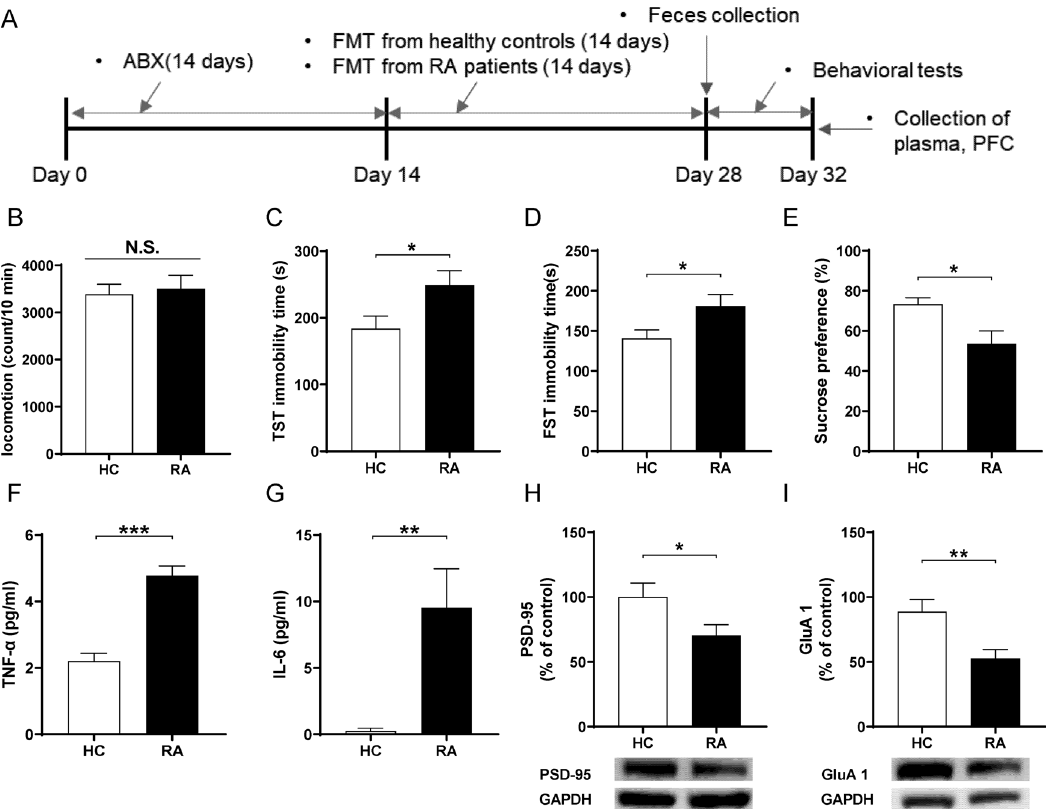
Fig. 2 Effects of FMT from RA patients and healthy controls in ABX-treated mice. A Schedule of treatment, behavioral tests and sample collection. B LMT (Student t -test: t = − 0.331, P = 0.744). C TST (Student t -test: t = − 2.288, P = 0.034). D FST (Student t -test: t = − 2.302, P = 0.033). E SPT (Student t -test: t = 2.738, P = 0.012). F Plasma TNF- α levels (Student t -test: t = − 6.932, P < 0.001). G Plasma IL-6 levels (Student t -test: t = − 3.156, P = 0.005). H PSD-95 (Student t -test: t = 2.174, P = 0.043). I GluA1 (Student t -test: t = 3.132, P = 0.006). Data are shown as mean ± S.E.M. ( n = 10). * P < 0.05, ** P < 0.01, *** P <